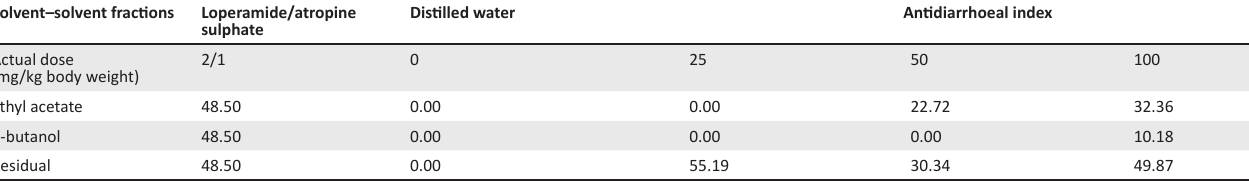
TABLE 4: Antidiarrhoeal index of the fractions of aqueous extract of Mangifera indica leaves. Solvent–solvent fractions Loperamide/atropine sulphate